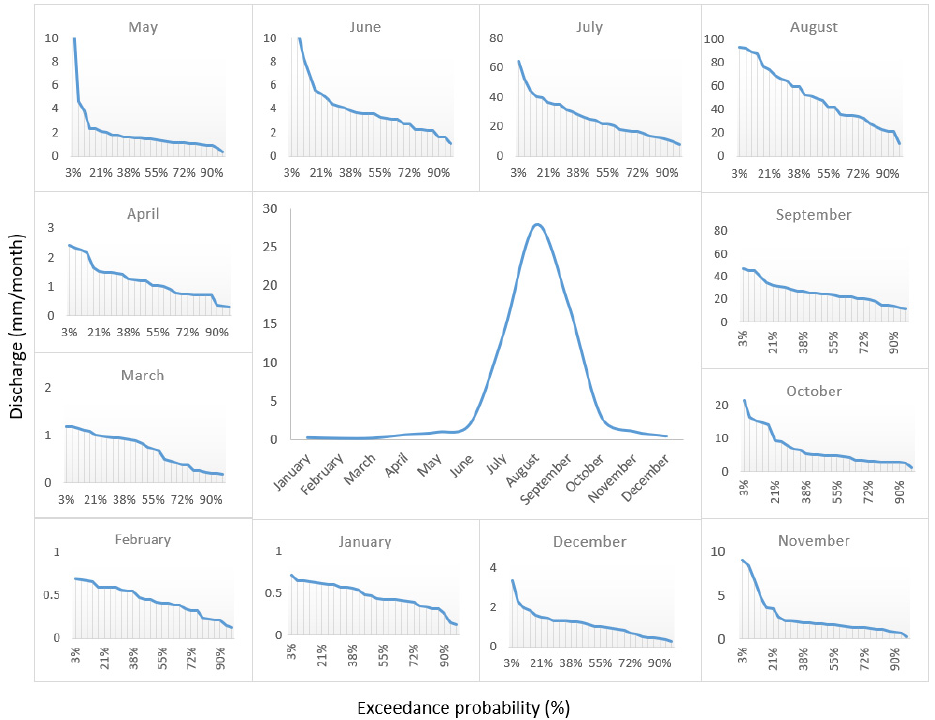
Figure 5. Derivation of monthly threshold level from monthly streamflow duration curves for Em- bameder station for the pre-impact period (1981–2008) (graphical representation adopted from [16]). Following a similar approach, the 80% thresholds adopted for precipitation to eval- uate the timing and magnitude of drought characteristics in the main river are included in Figure 6. This evaluation was conducted with regard to precipitation variabilities in the contributing headwater catchments.